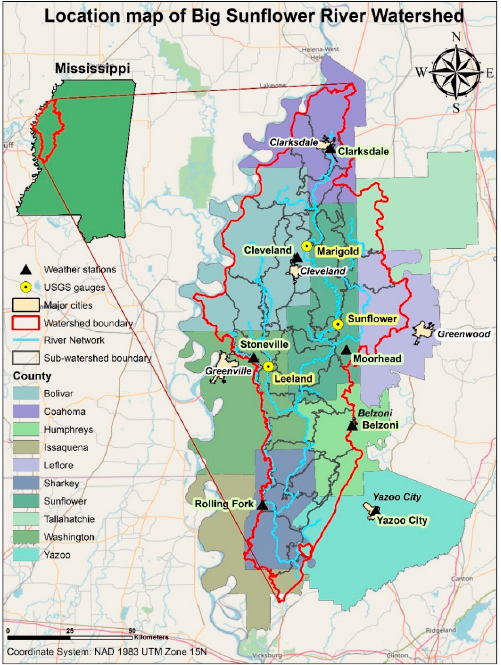
Figure 1. Location of study area: Big Sunflower River watershed, showing weather stations, USGS gauge stations, major cities, counties, sub-watershed, and river network.